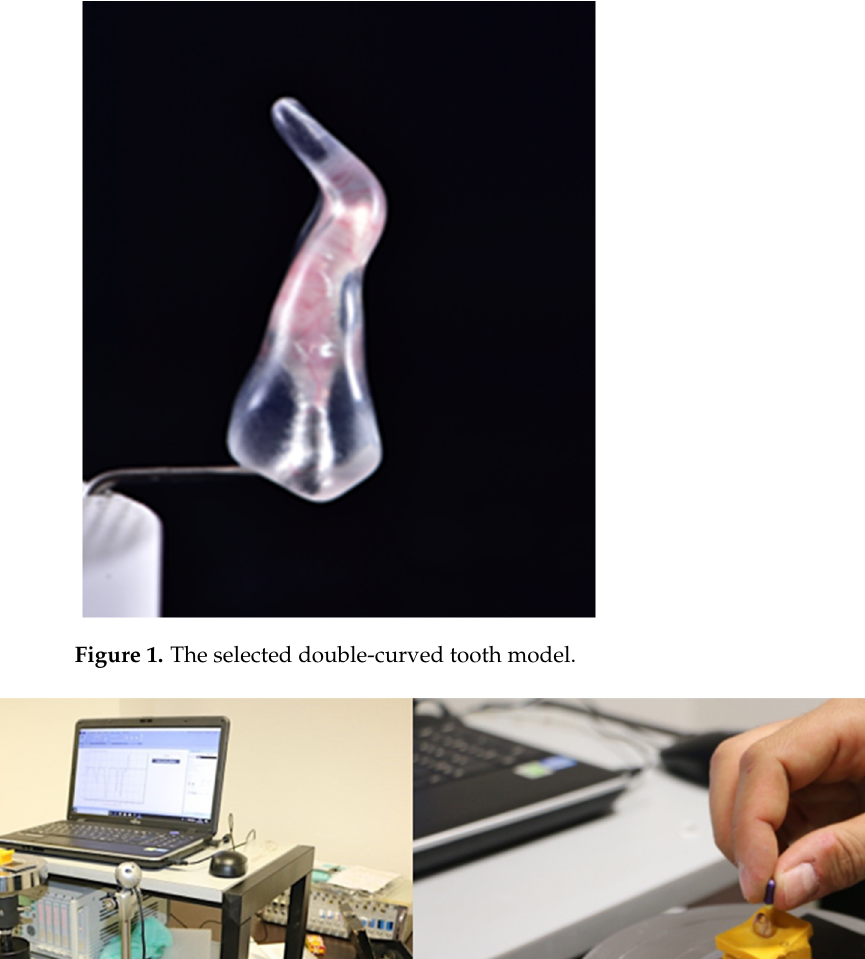
Figure 1. The selected double ‐ curved tooth model.